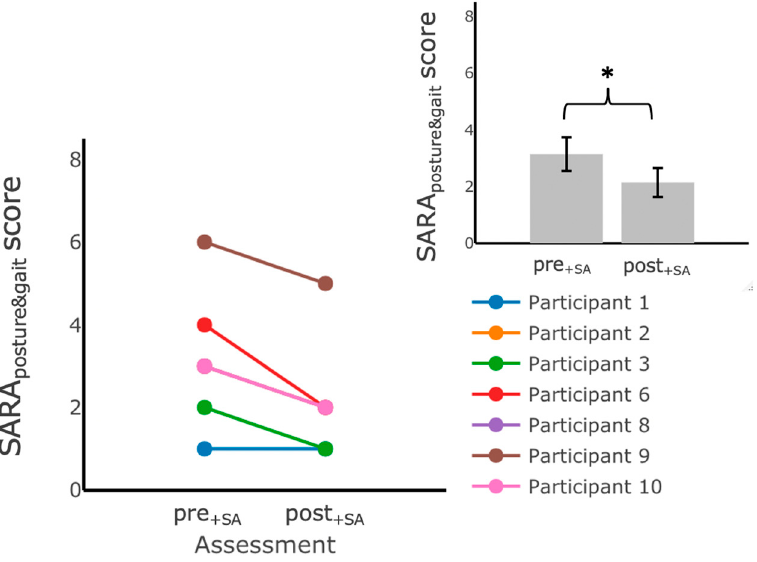
Figure 7. SARA posture&gait scores measured during assessments performed in the laboratory before ( pre + SA ) and after ( post + SA ) training at home with vibrotactile SA. Participants scored significantly lower on the SARA posture&gait after training with vibrotactile SA. The main plot shows individual trends for the participants’ SARA posture&gait scores and the inset shows the average SARA posture&gait scores. Error bars on the bar plot indicate SEM values. (*) indicates statistically significant changes ( p < 0.05) .